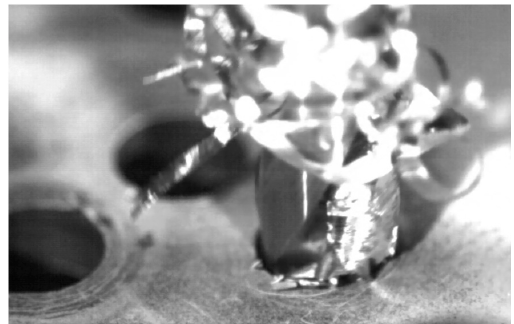
Figure 14. Chip removal during stacking drilling CFRP/UNS A97075 using conventional technology.